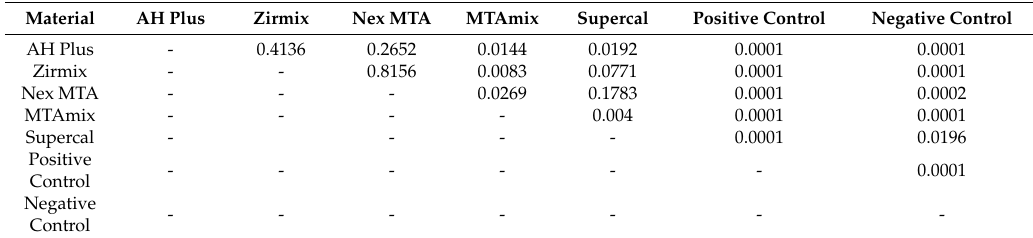
Table 3. Summary of differences between groups